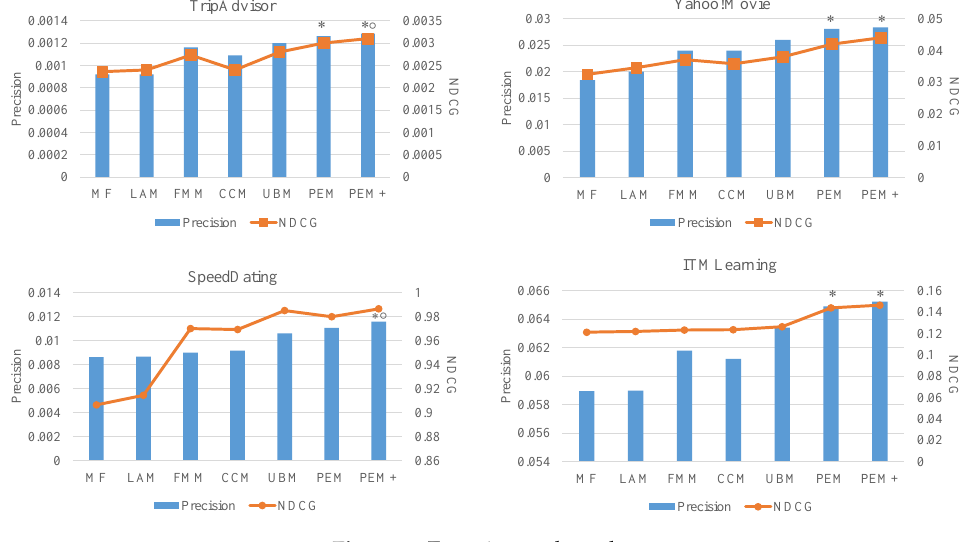
Figure 2. Experimental results. Table 3. Results based on normalized discounted cumulative gain